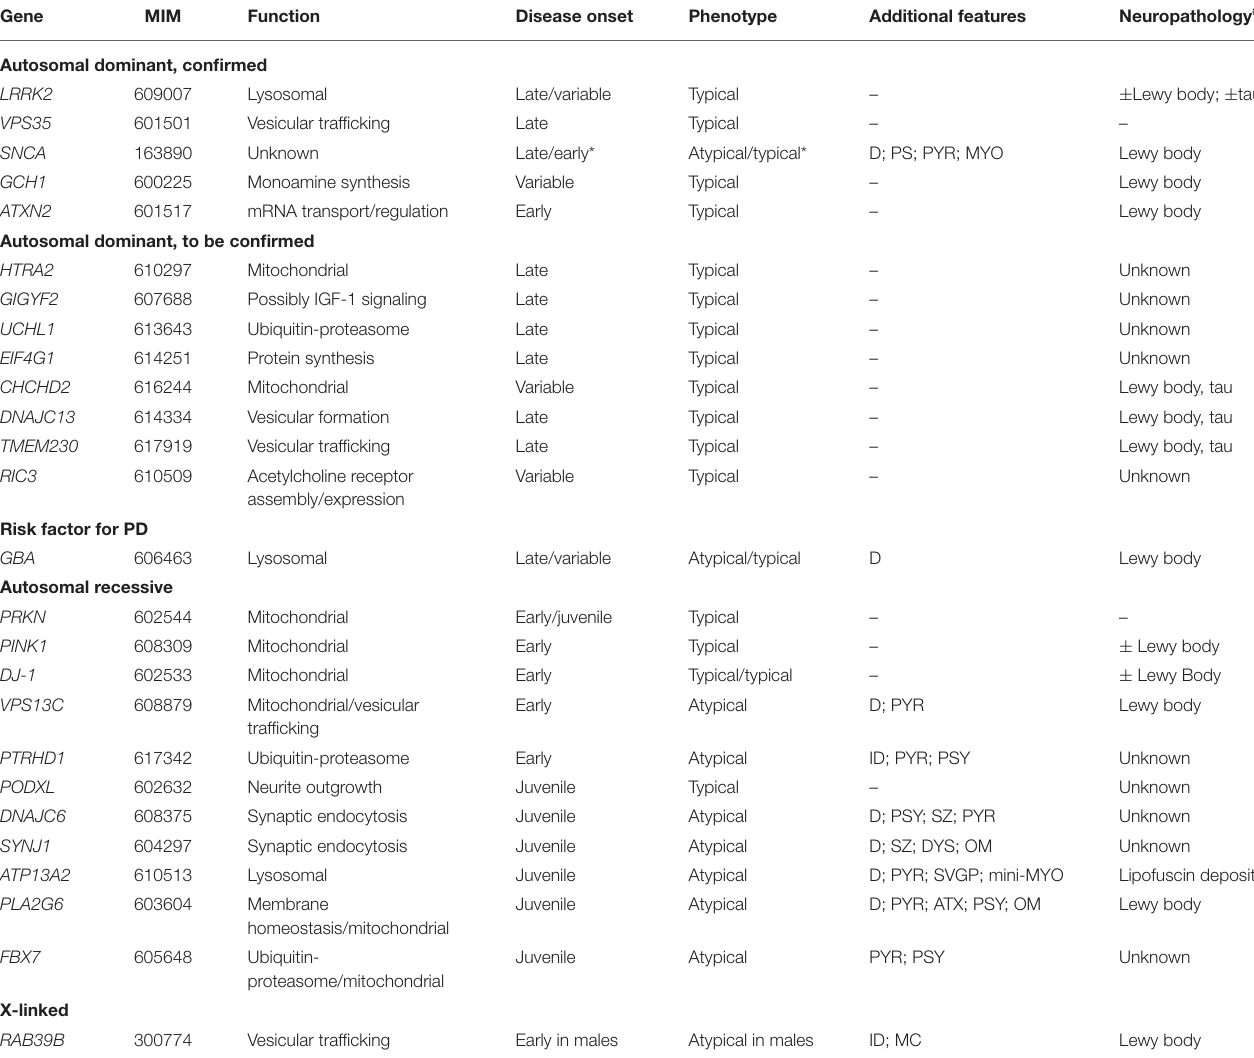
TABLE 1 | Genes causing Parkinsonian conditions and related